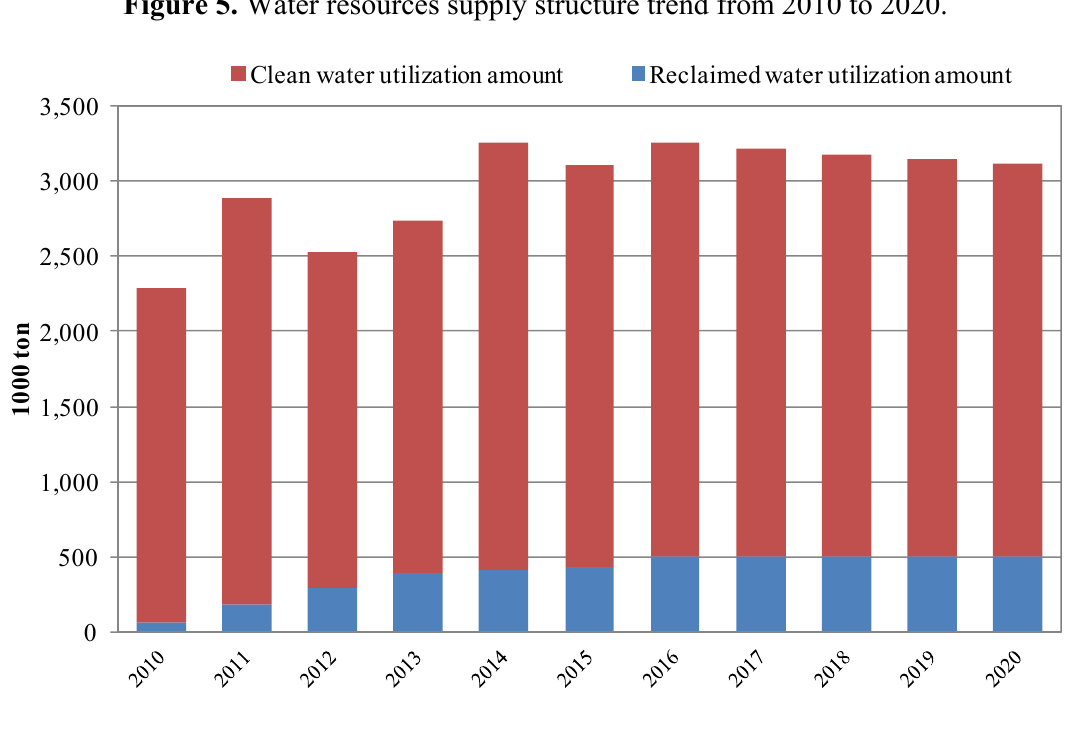
Figure 5. Water resources supply structure trend from 2010 to